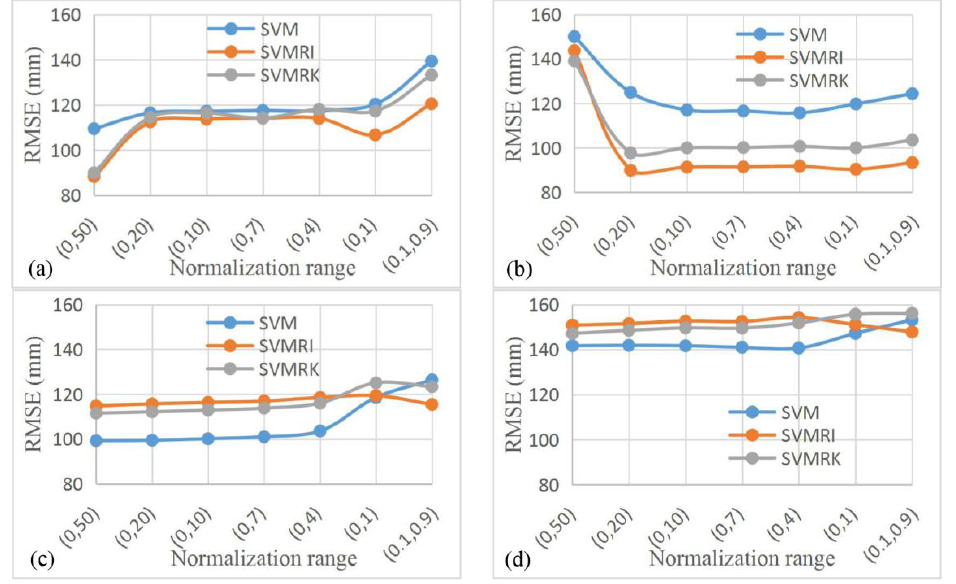
Figure 10. Comparison of normalization ranges (( a ) Y-E-T; ( b ) Y-E-T fs ; ( c ) Y-E 10 -T; ( d ) Y-E 10 -T fs ).